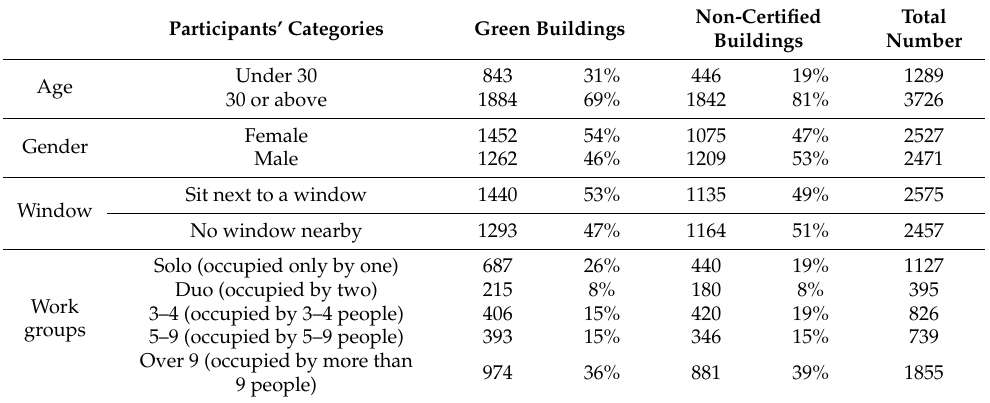
Table 3. The distribution of individual occupant responses in terms of personal and spatial factors.